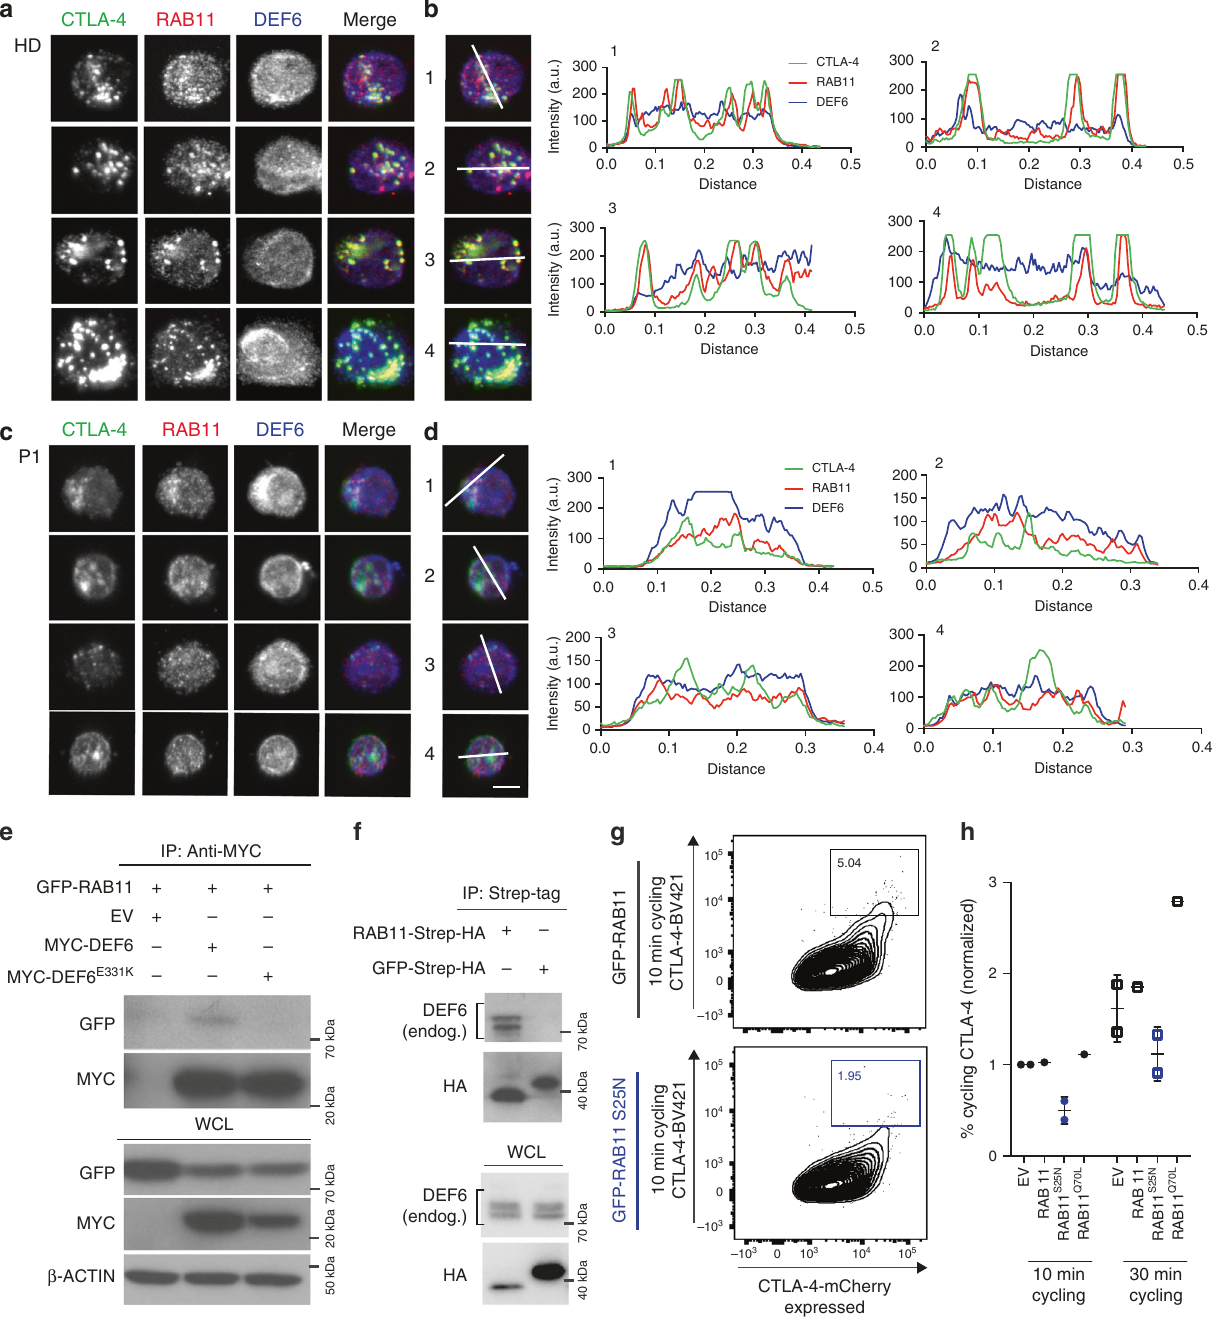
GTPase RAB11. Presence of mutation E331K abrogated this interaction. Samples were balanced on immunoprecipitated GFP-RAB11 fractions and blotted for interacting DEF6. Representative of three independent experiments. f Endogenous DEF6 co-immunoprecipitates from Jurkat lysates with overexpressed RAB11-Strep-HA, compared to GFP-Strep-HA control. Samples were balanced on immunoprecipitated HA-tag fractions. Western blots ( e , f ) were cropped for visualization. g , h Overexpressing inactive RAB11 S25N in Jurkat-mCherry-CTLA-4 cells mimics DEF6-de fi cient defects in CTLA-4 cycling. Cells were cycling CTLA-4 after 10 min and 30 min, respectively. Cycling was reduced in RAB11 S25N expressing cells (blue, blue numerical insert, g), while RAB11 Q70L enhanced cycling at 30 min ( h ). Data are overlaid with mean ± SD. Representative of two individual experiments. Source data of Fig. 6 including